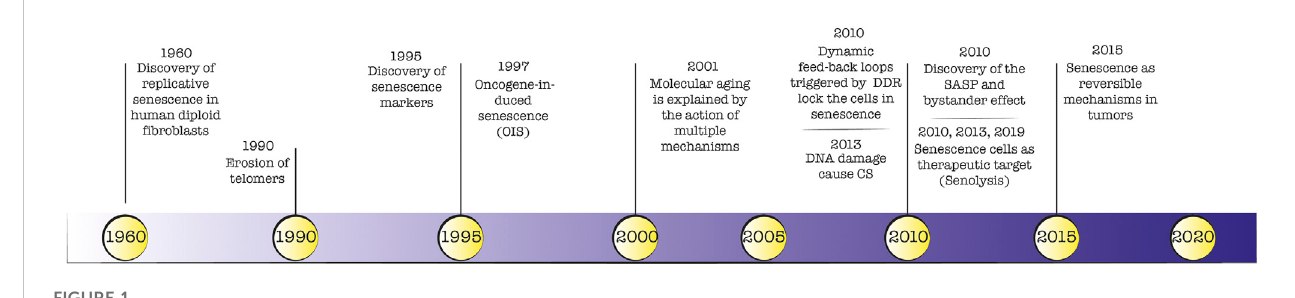
FIGURE 1 Timeline of senescence landmark